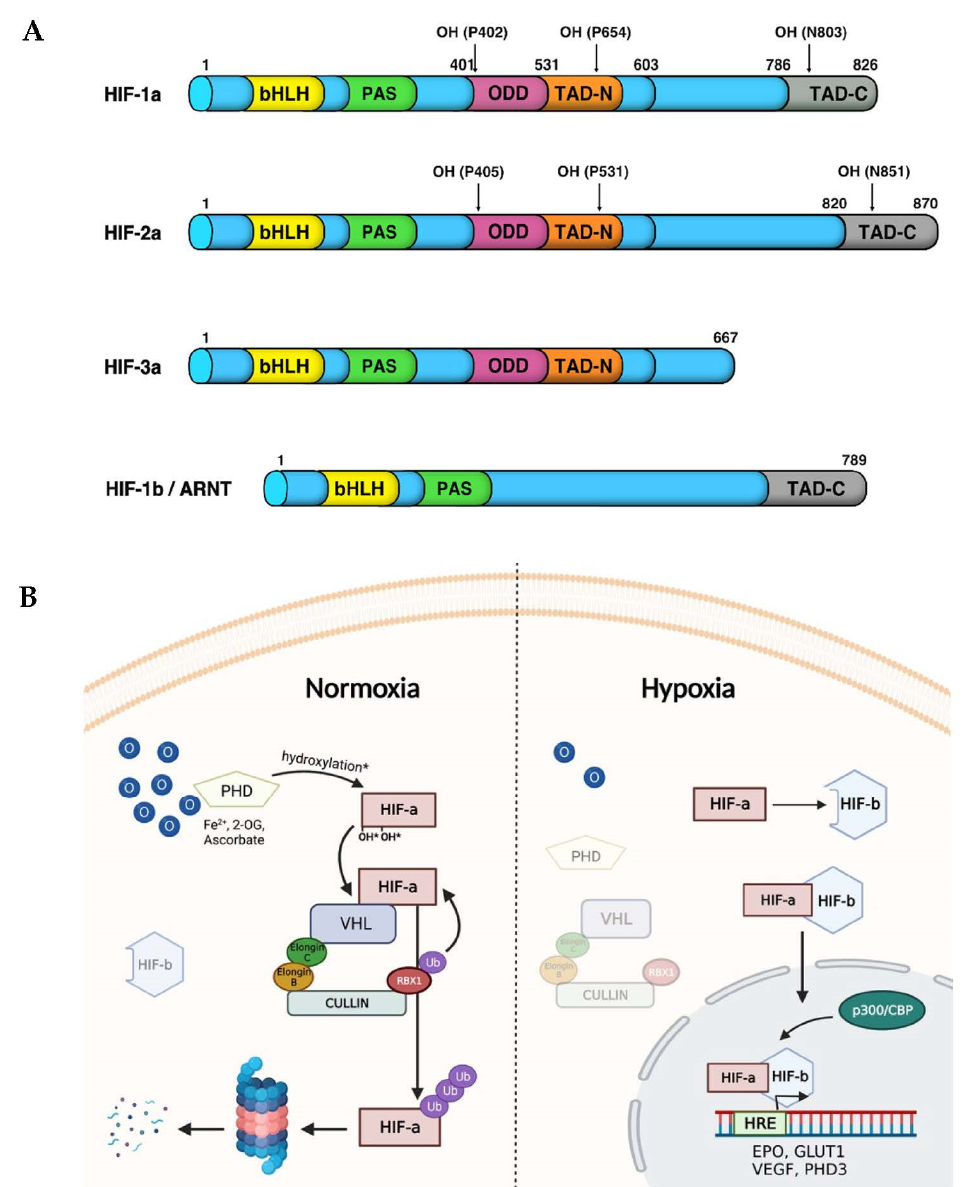
Figure 3. HIF- α isoforms and their receptor HIF-1 β /ARNT structural domains. ( A ) In vertebrates both HIF-1 α and HIF-2 α , but not HIF-3 α , contain a basic helix-loop-helix (bHLH) domain, a Per-Arnt-Sim domain (PAS), an oxygen dependent degradation (ODD) domain, an N-terminal transactivation domain (N-TAD) located in the ODD and a C-TAD localized in the C-terminal region. ( B ) The HIF signalling pathway. Under normoxic conditions, PHDs hydroxylate HIF- α subunits on two